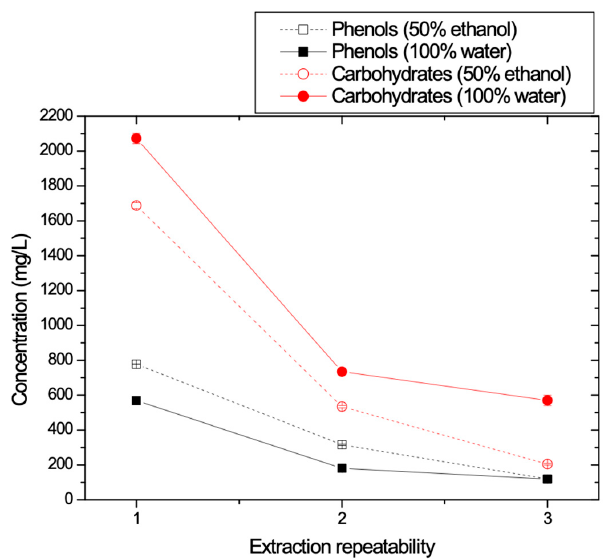
Figure 6. TPC and Carbohydrates concentration values versus repeatability with respect to the solid residue.